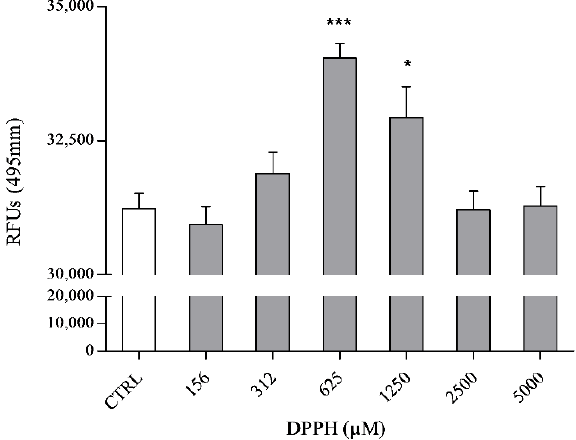
Figure 5. ELISA assay for the assessment of Prostaglandin E 2 serum-release induced in PNT2 cells by six DPPH concentrations (156, 312, 625, 1250, 2500 and 5000 µ M). Values are expressed as relative fluorescent units (RFUs) normalized by the protein concentration of total cell lysate and represented as the mean ± SD of PGE 2 concentrations. Asterisks indicate statistically significant differences compared to the control (* p ≤ 0.05, *** p ≤ 0.001; Dunnett’s test).